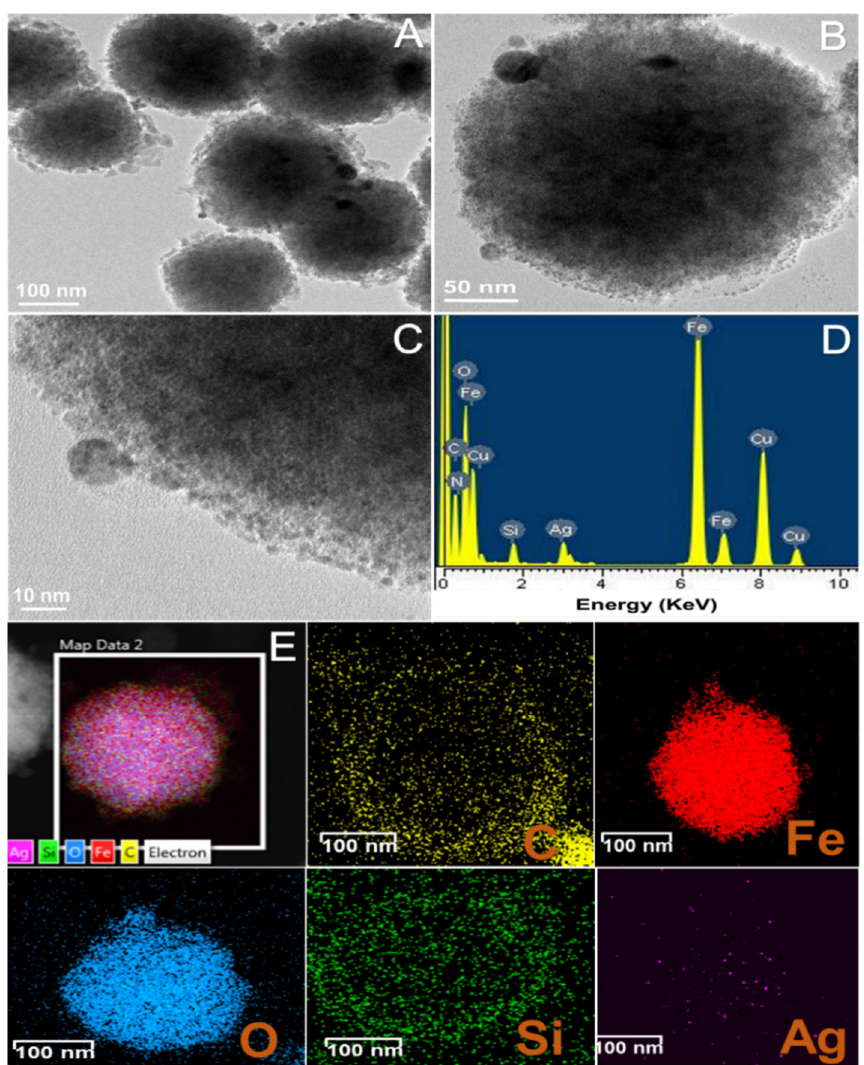
Figure 4. ( A – C ) HR-TEM images, ( D ) EDS spectrum analysis, and ( E ) elemental dot mapping of Ag-BSiO 2 -Fe 2 O 3 hybrid structure.